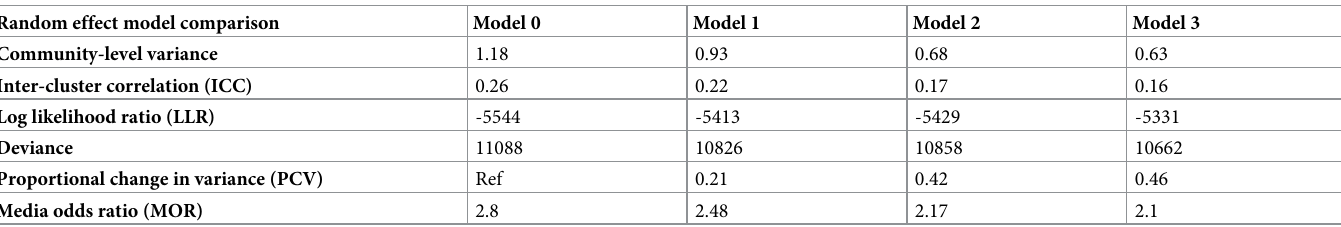
Table 2. Model comparison and random effect distribution regarding vitamin A supplementation among children aged 6–59